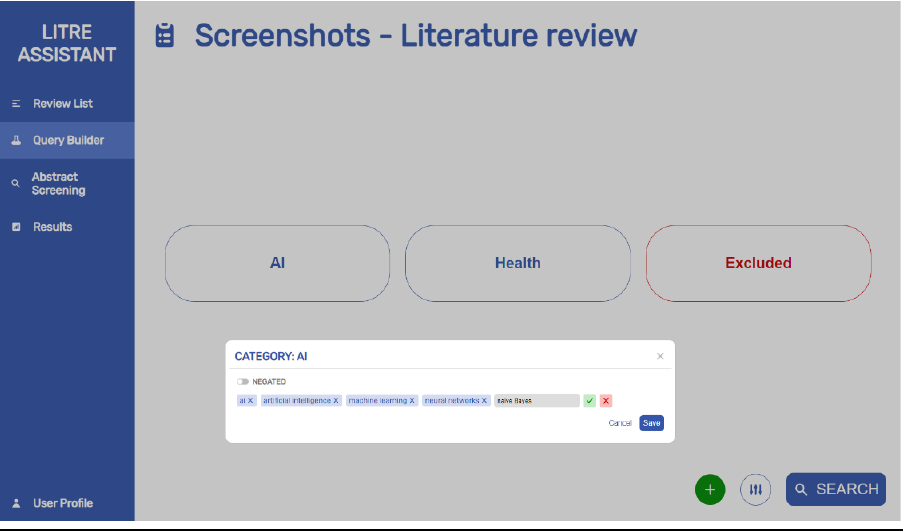
Figure 6. Query Builder feature of the Litre Assistant system for designing query categories and subcategories.